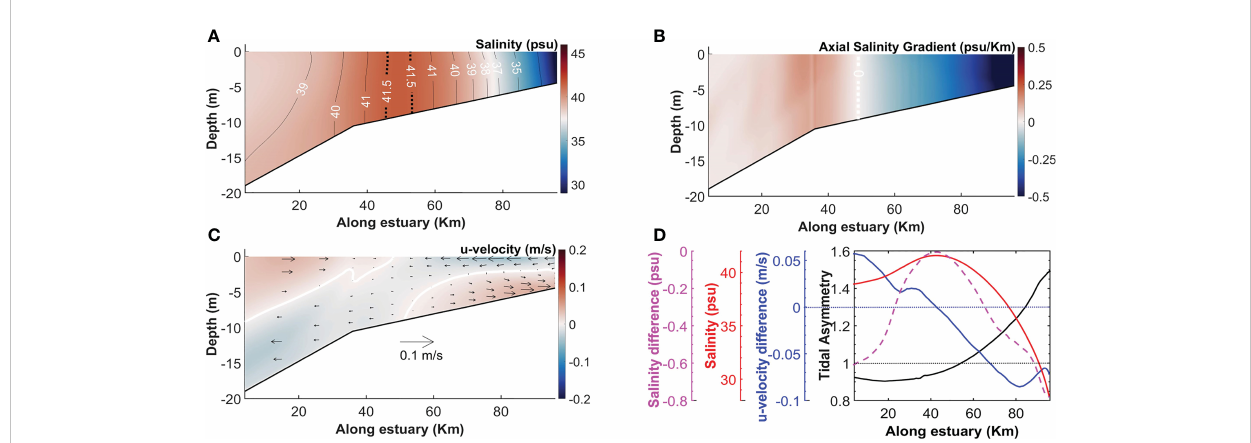
FIGURE 2 Along-channel pro fi les of time-averaged salinity (A) , axial salinity gradients ( ∂ s ∂ asymmetry along with the time-averaged surface and bottom differences in axial velocity, depth-mean salinity, and surface and bottom differences in salinity are plotted in (D) with different lines. The white dotted line in (B) is zero- ∂ s ∂ lines in (C) represent the positions of zero-velocities. The landward direction in the velocity differences is positive in (D)